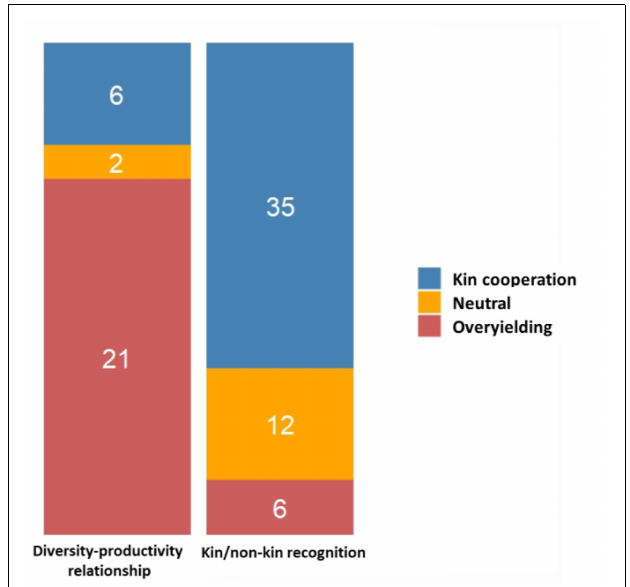
FIGURE 4 | Stacked barplots illustrating the relative proportion of kin cooperation (KC), overyielding (OY) and neutral interactions between the ‘diversity-productivity relationship’ and ‘kin/non-kin recognition’ rationales. The number of studies supporting each type of interaction are indicated within each stack.